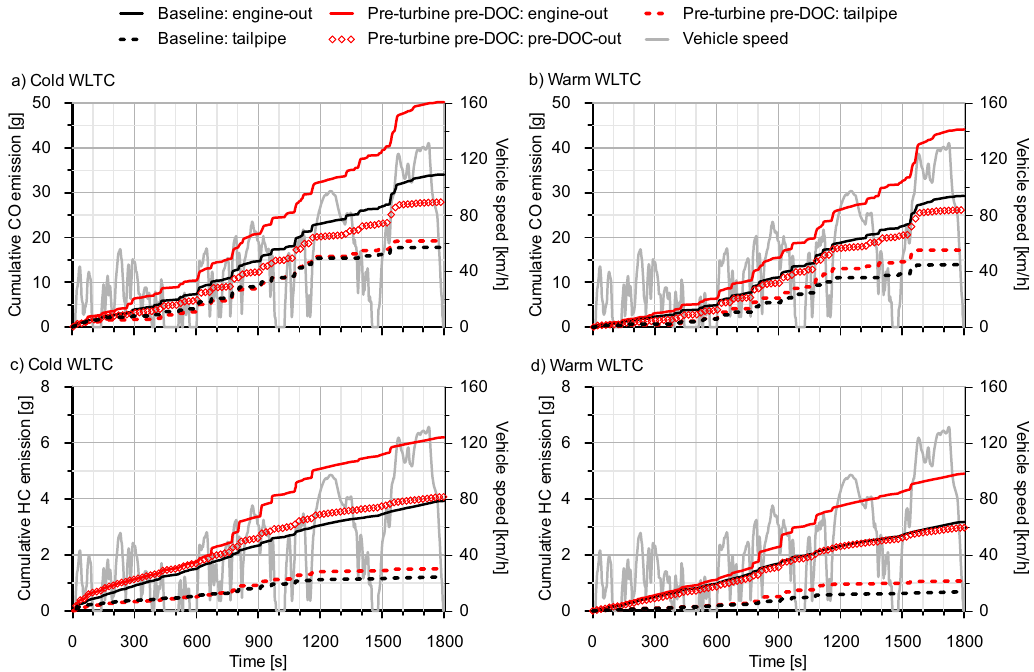
Figure 8. Cumulative CO and HC emission along the exhaust line in cold and warm WLTCs with baseline ATS and pre-turbine pre-DOC configurations. ( a ) Cumulative CO emission in cold WLTC, ( b ) cumulative CO emission in warm WLTC, ( c ) cumulative HC emission in cold WLTC, ( d ) cumulative HC emission in warm